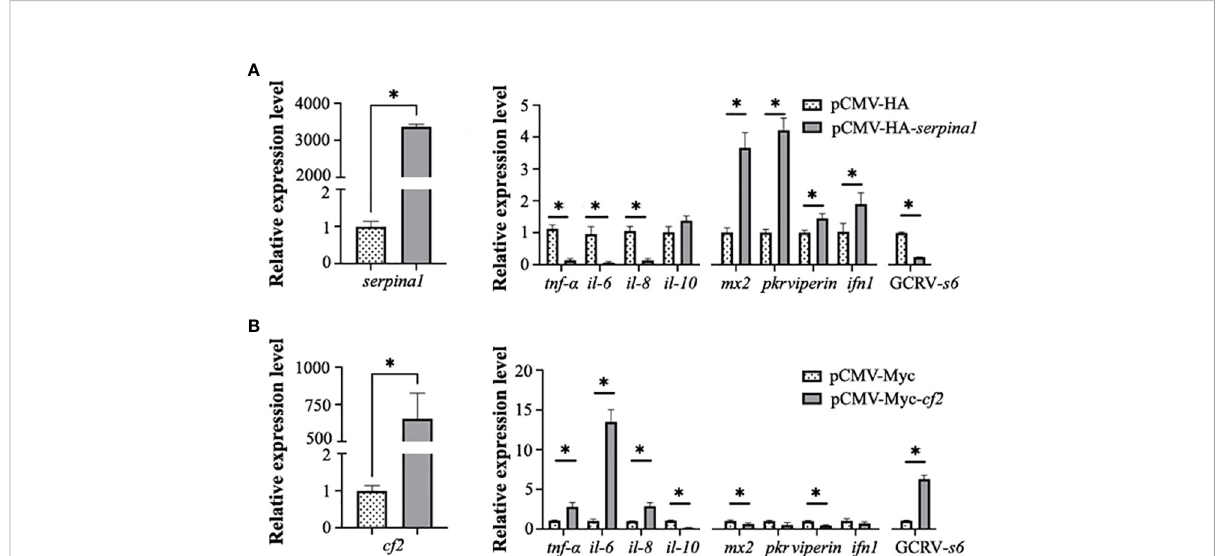
FIGURE 5 Serpina1 and cf2 overexpression alone affects the cellular in fl ammatory response and GCRV infection. (A) Changes in serpina1 expression level in cells were detected after serpina1 overexpression (left). The relative expression levels of related cellular in fl ammatory factors, antiviral genes, and GCRV- s6 were also detected (right). The horizontal coordinates are related genes and the vertical coordinates indicate the relative expression levels. (B) Changes in the expression of cf2 in cells were detected after cf2 overexpression. The relative expression levels of related cellular in fl ammatory factors, antiviral genes, and GCRV- s6 were also detected. The horizontal coordinates are related genes and the vertical coordinates indicate the relative expression. The expression level of transfected null was set as “ 1 ” as control, and “ * ” indicates p <